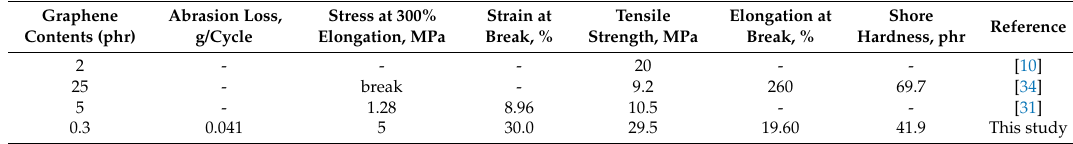
Table 3. A comparison with other studies on graphene/rubber composite.